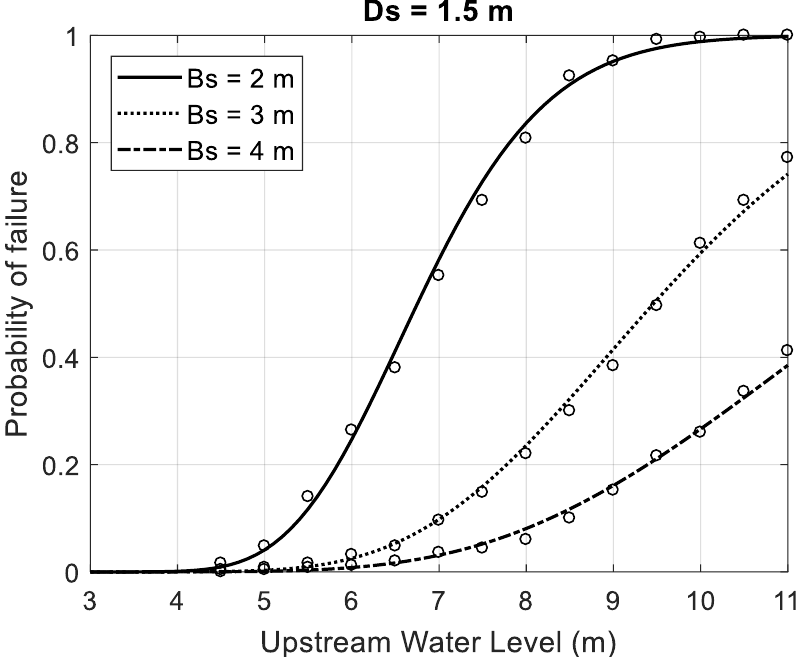
Fig. 9. Fragility curves for failure due to rupture for fixed 𝐷